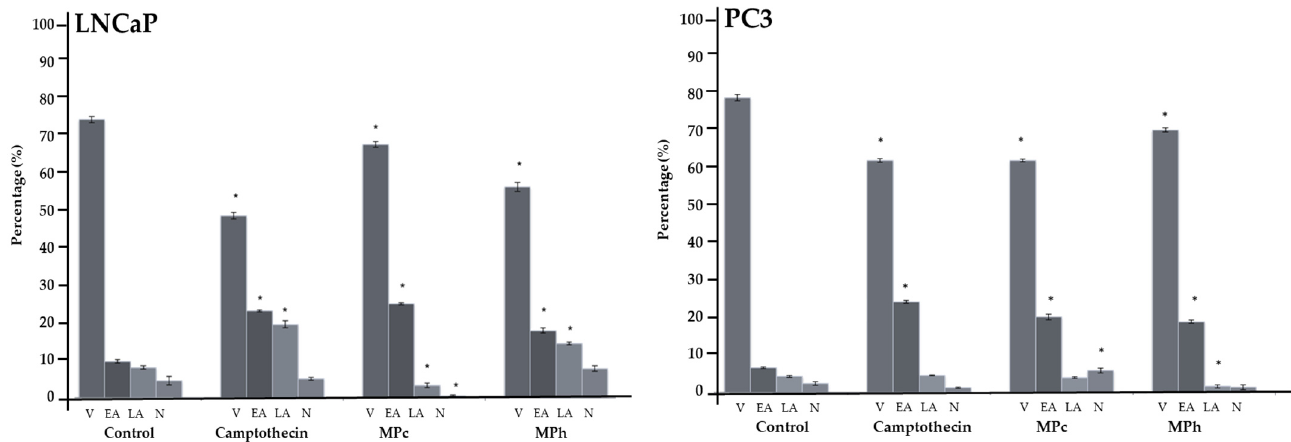
Figure 2. Flow cell cytometry analyses using Annexin V-FITC and PI staining of LNCaP and PC3 cells after 6 h of treatment with the cytotoxic extracts of Marantodes pumilum or camptothecin (positive control). V = viable cells; EA = early apoptotic cells; LA = late or secondary apoptotic cells; N = necrotic cells. The error bars display the standard error of the mean (SEM) obtained from 3 independent experiments. Significance compared to control, * ( p < 0.05) as determined via unpaired t -test.